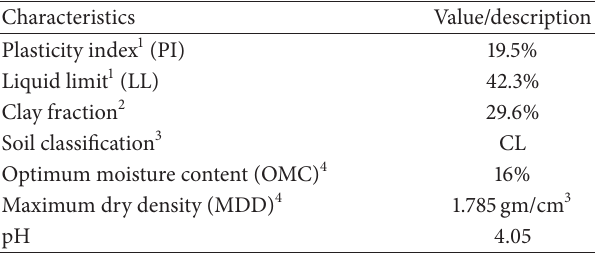
Table 3: Characteristics of UKM